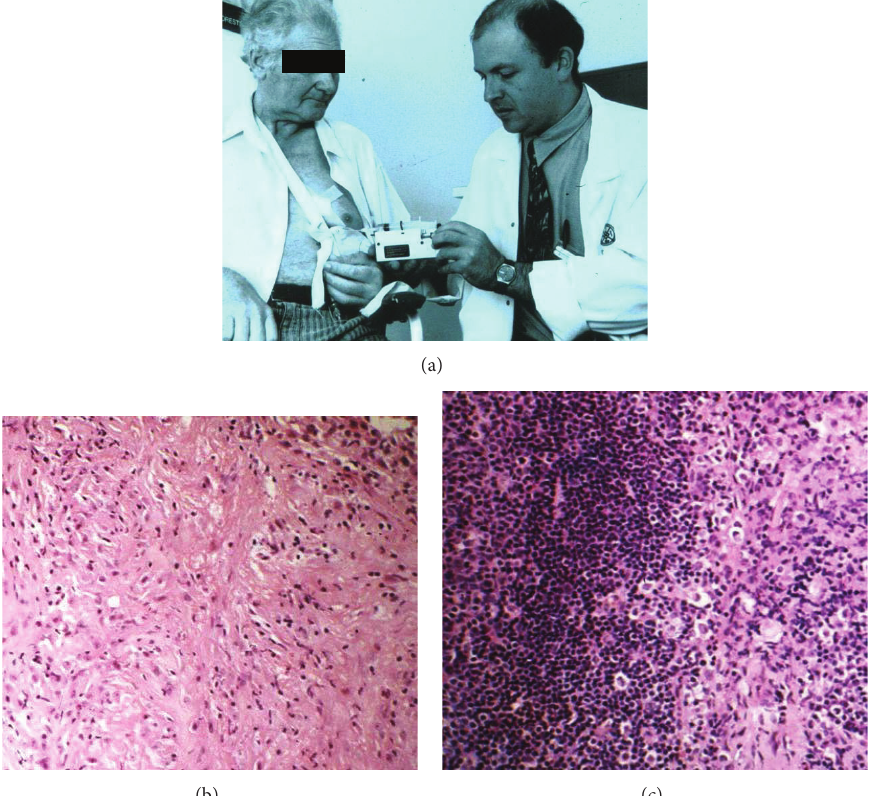
Figure 3: Induction of local and widespread antitumor reactivity with continuous cytokine infusion into tumors. Recombinant human GM- CSF was administered continuously into the tumor of a patient with pleural mesothelioma using a pump attached to an intratumoral cathers via a subcutaneous port (a) Tumor biopsies (H&E) taken before (b) and after (c) 8 weeks of continuous intratumoral infusion of GM-CSF. Shown is a marked influx of immune cells into uninfused tumor following the therapy. This patient exhibited a generalized partial response ( > 50% diffuse tumor